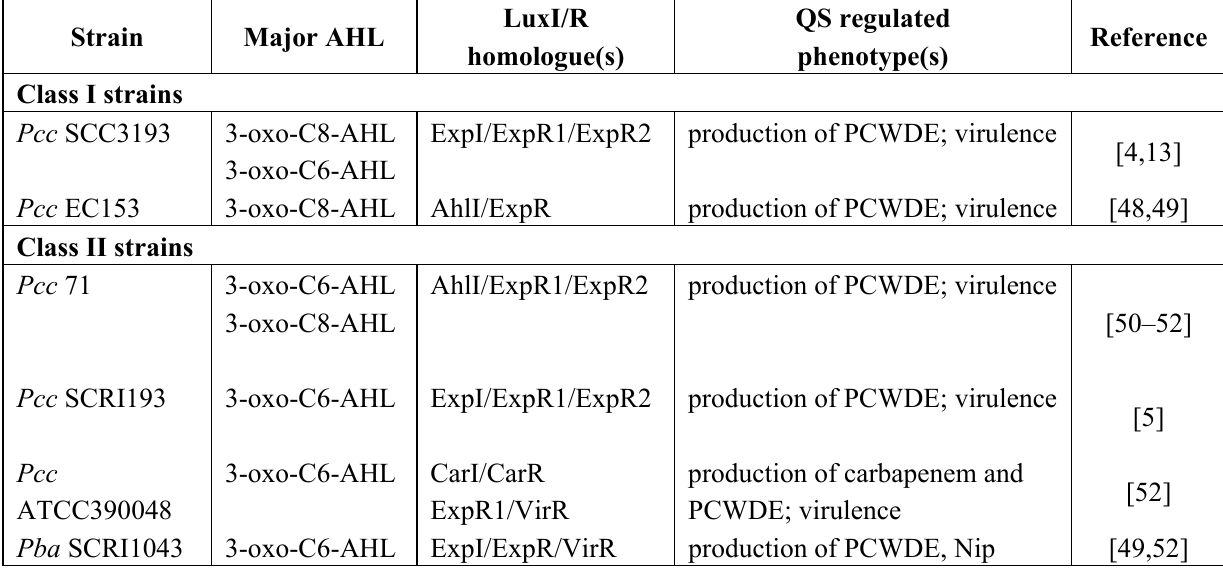
Table 1. AHL quorum sensing systems of class I and class II